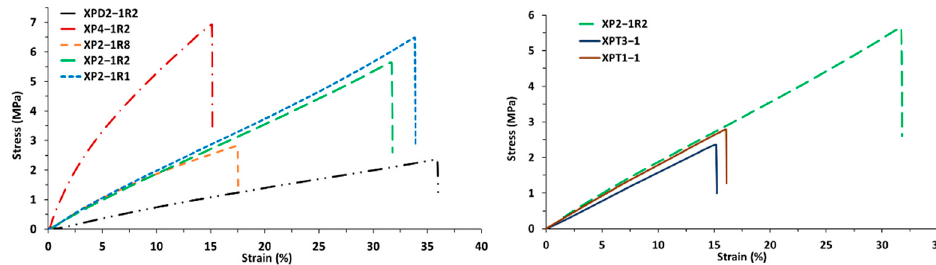
Figure 6. Uniaxial tensile test. Stress–strain curves for the different xerogels.